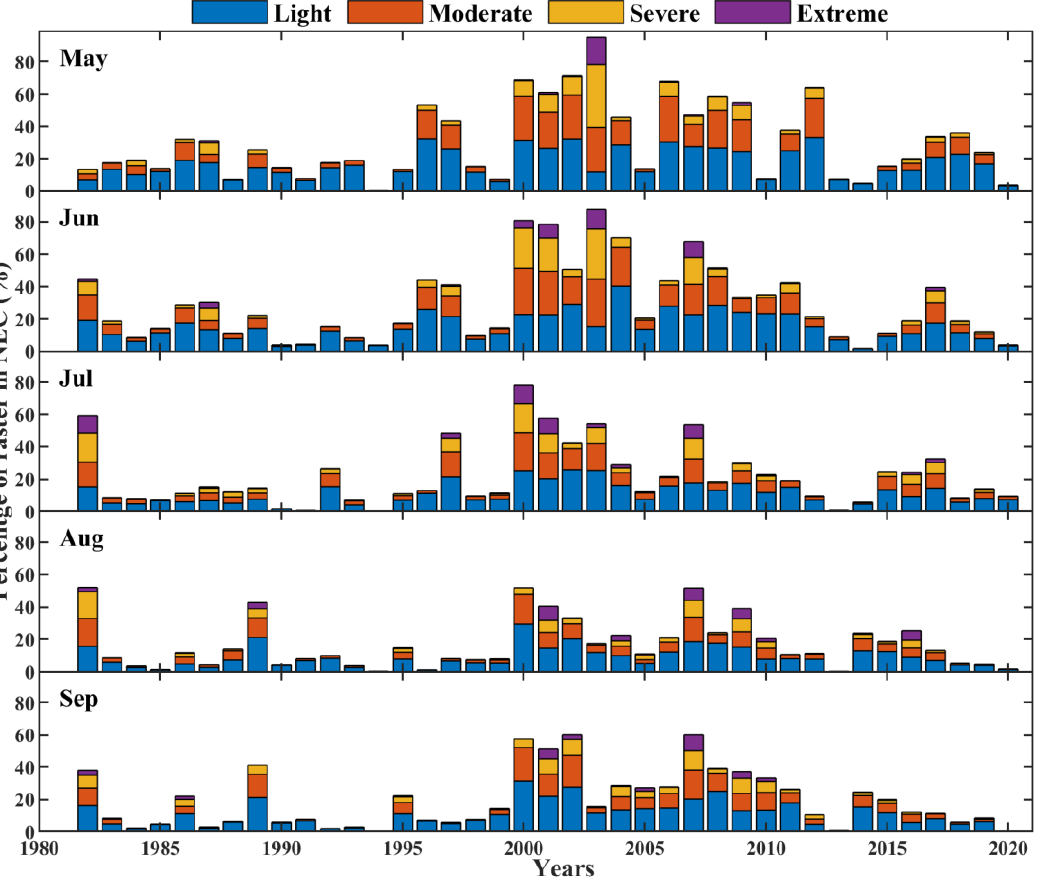
Figure 9. Temporal changes in drought impact scope based on the CDI during the growing season in NEC from 1982 to 2020.